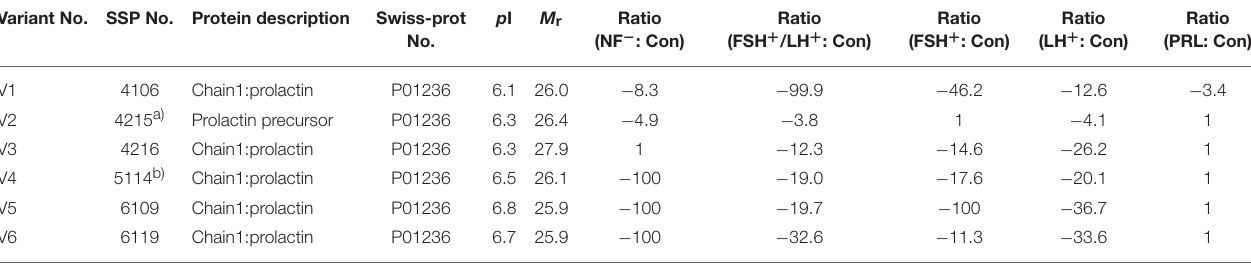
TABLE 3 | Prolactin variants changed in different subtypes of pituitary adenomas relative to control pituitaries. Variant No. SSP No. Protein description